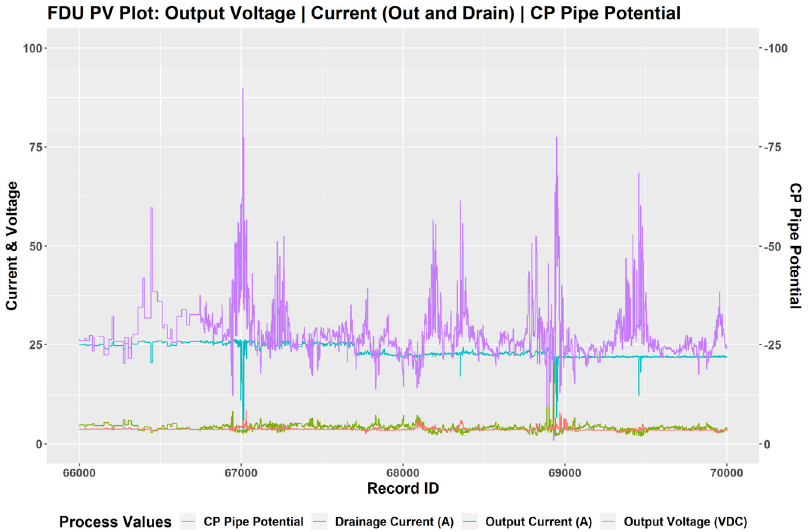
Figure 9. ICCP unit variables (FDU with stray current).